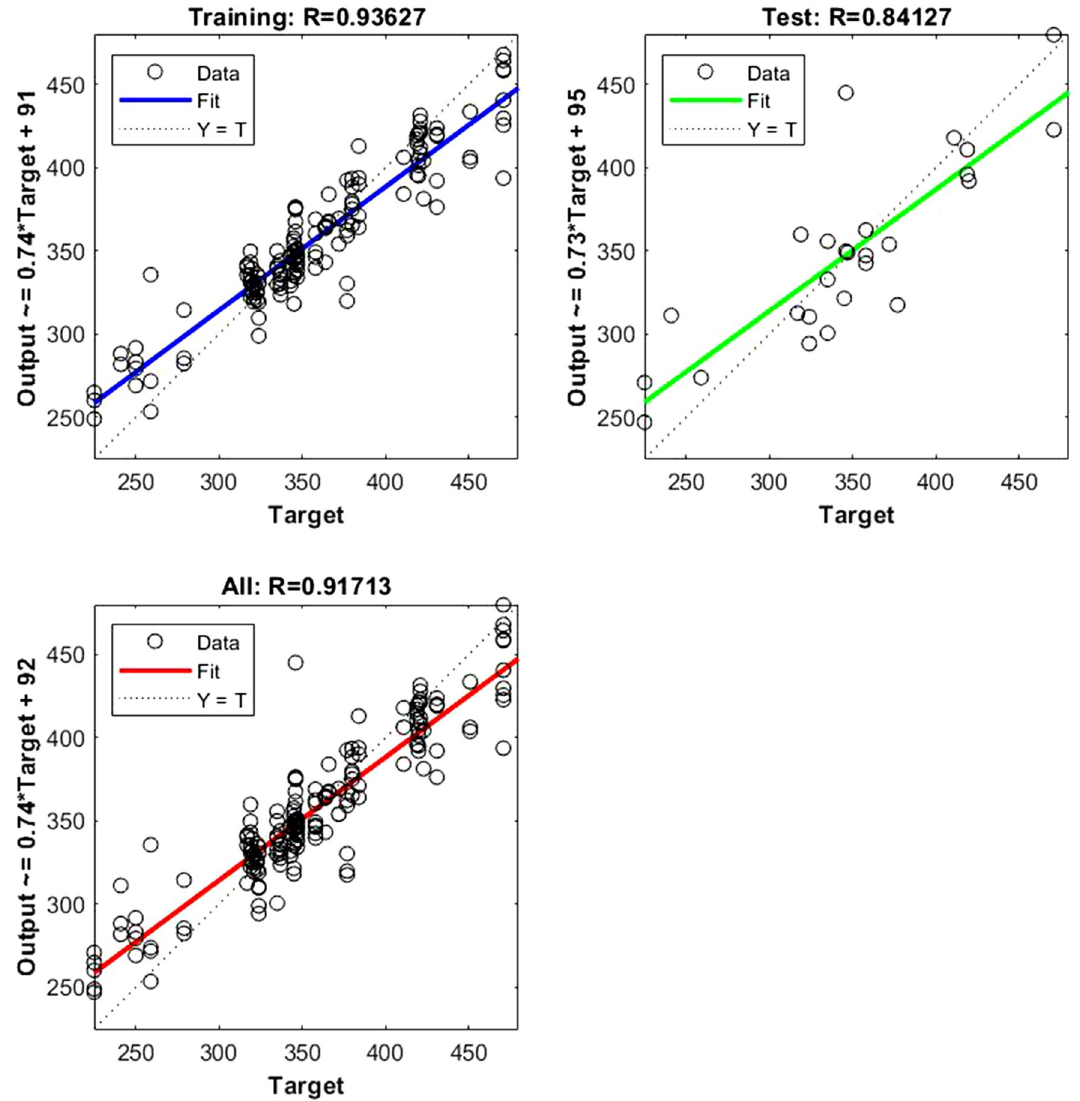
Figure 6. Represents the regression plot between the NIR-absorbance of spent dialysate and the FER concentration in the patient blood at the beginning of the hemodialysis session (wavelength from 700–1700 nm, Rall = 0.91, R train = 0.93, R test = 0.84, number of spectra used for training was N = 108). The equation relating the predicted and measured values is Output = 0.74*Target +